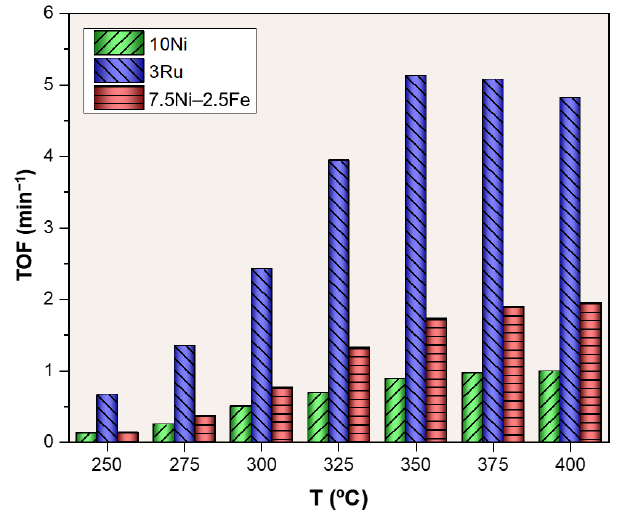
Figure 5. Comparison of specific activity of three catalysts tested (‘W/O CH 4 ’) in terms of TOF (Equation (7)). Operating conditions: same as in Figure